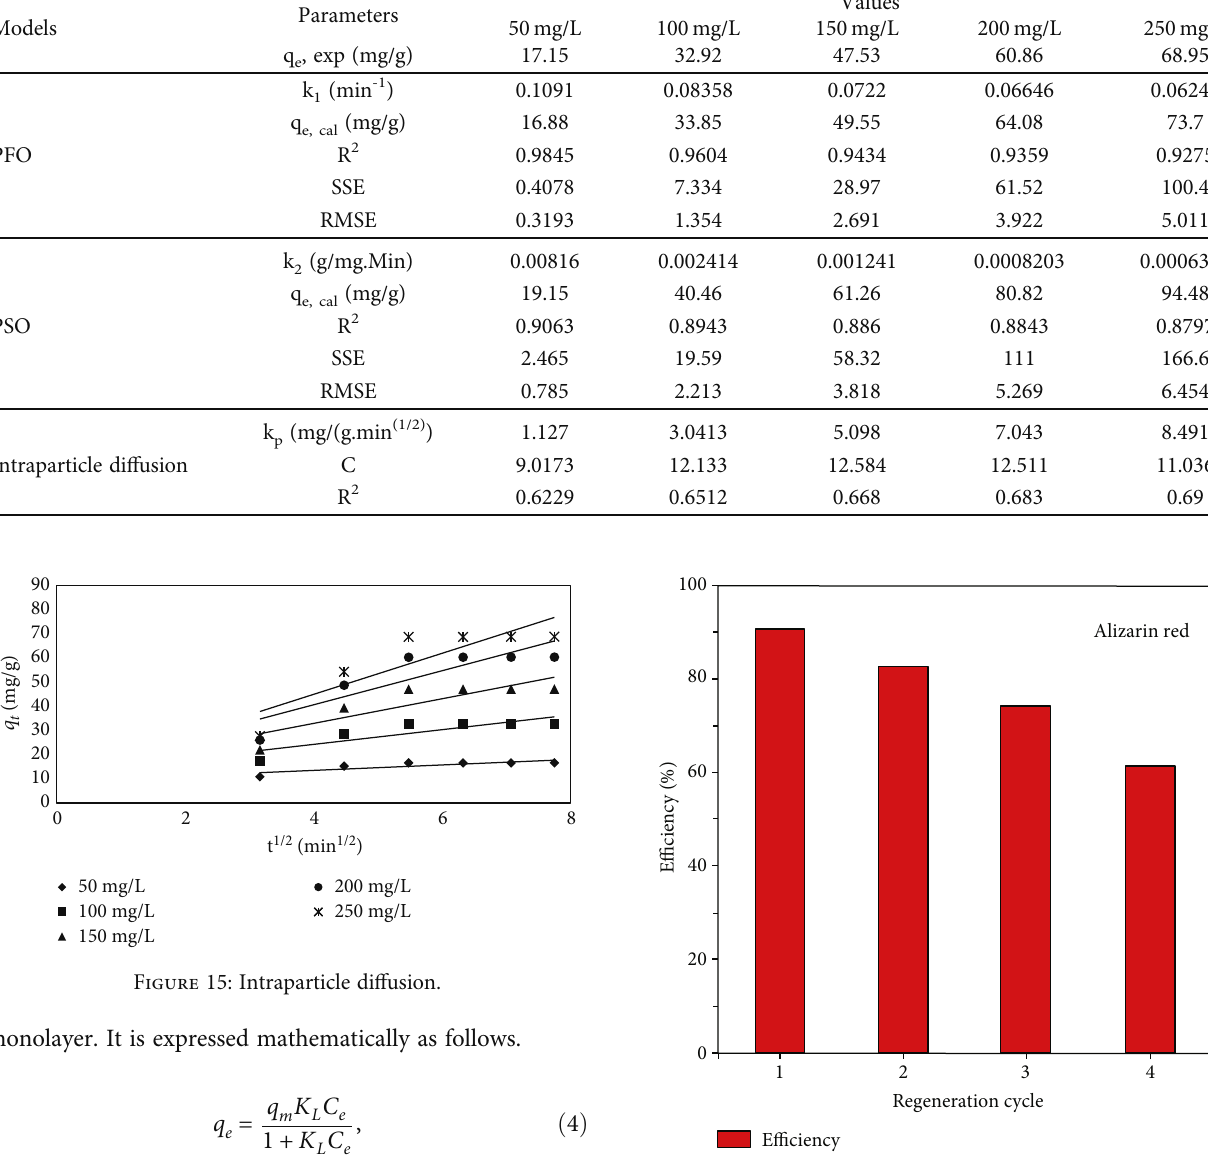
Figure 16: Regeneration of CTASP adsorbent.